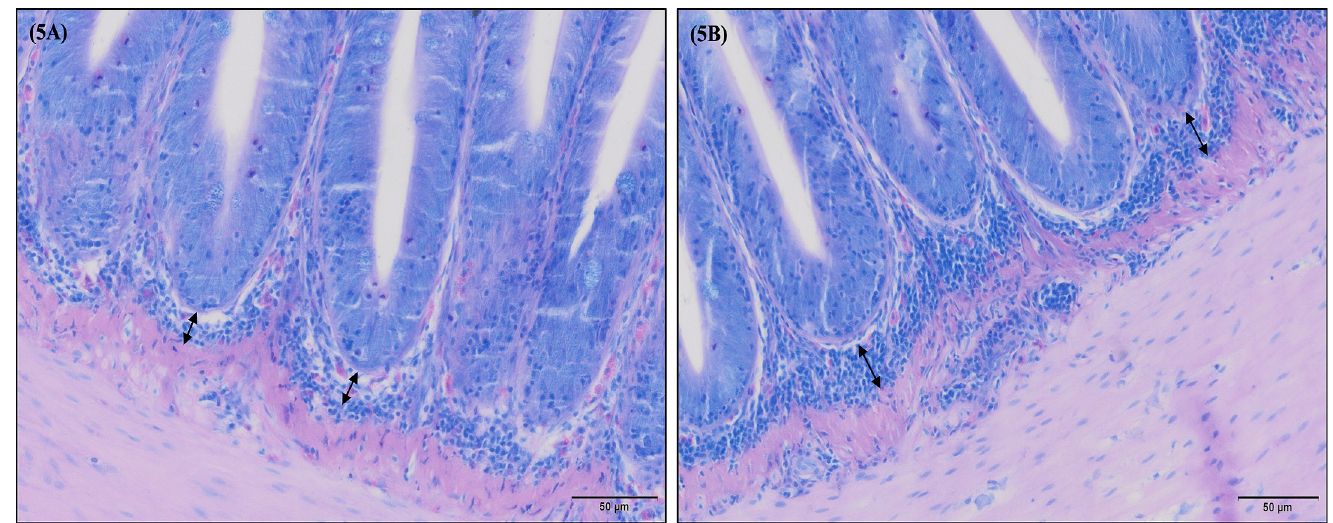
Fig 5. European sea bass ( Dicentrarchus labrax ) rectum submucosa thickness after 63 days of dietary supplementation (May-Gru¨nwald Giemsa). The thinner rectum submucosa pattern observed is represented in Fig 5A and corresponds to fish fed GMOS and GMOSPHYTO diets. Bar 50 μ m. The engrossed rectum submucosa pattern observed is represented in Fig 5B and corresponds to fish fed control and PHYTO diets. C (control diet), GMOS (5000 ppm galactomannan oligosaccharides), PHYTO (200ppm phytogenic), GMOSPHYTO (5000 ppm galactomannan oligosaccharides+200ppm phytogenic).